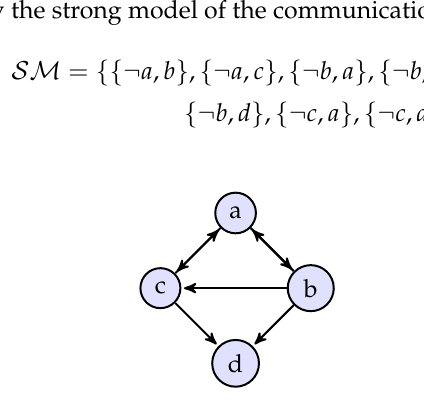
Figure 2. A communication graph with 4 vertices, 3